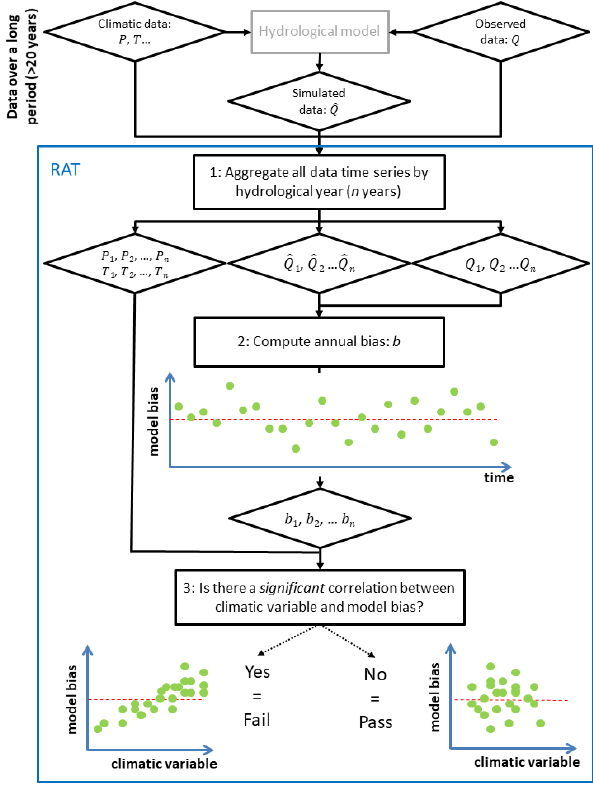
Figure 1. Flowchart of the robustness assessment